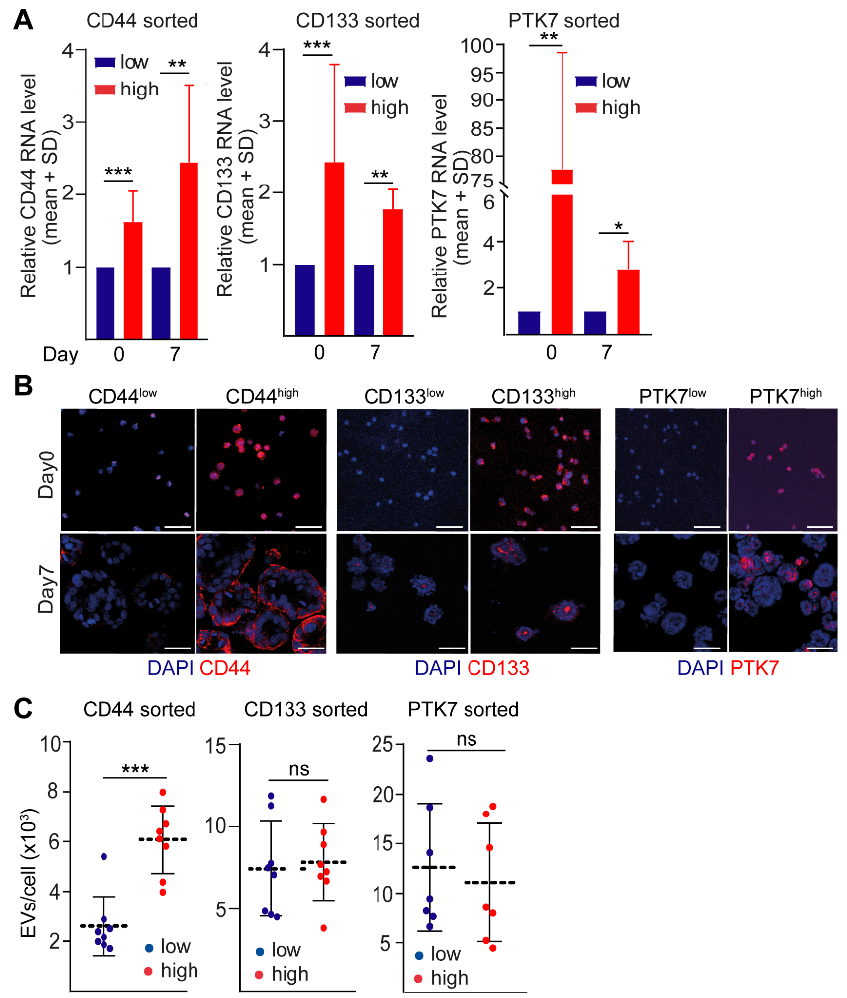
Figure 3. CD44 high cells release more EVs compared to CD44 low CRC cells. ( A ) Relative RNA levels for the indicated genes directly after sorting for CD44, CD133, or PTK7 (d0) or 7 days after organoid formation. Data were normalized to the housekeeping control and the expression level of the CD44 low , CD133 low or PTK7 low population was taken as 1 (RT–qPCR, n = 4 from four organoid lines). ( B ) Immunostaining for CD44, CD133, and PTK7 directly after sorting (d0) or 7 days after culturing (confocal microscopic analysis, organoid #3). ( C ) EV concentration in the supernatants of organoids 7 days after sorting (1–2 parallels from four organoid lines, normalized to cell number). Scale bars: 50 µ m ( B ). Paired t -test ( A ) and Mann–Whitney U test were used ( C ). * p < 0.05, ** p < 0.01, and *** p <